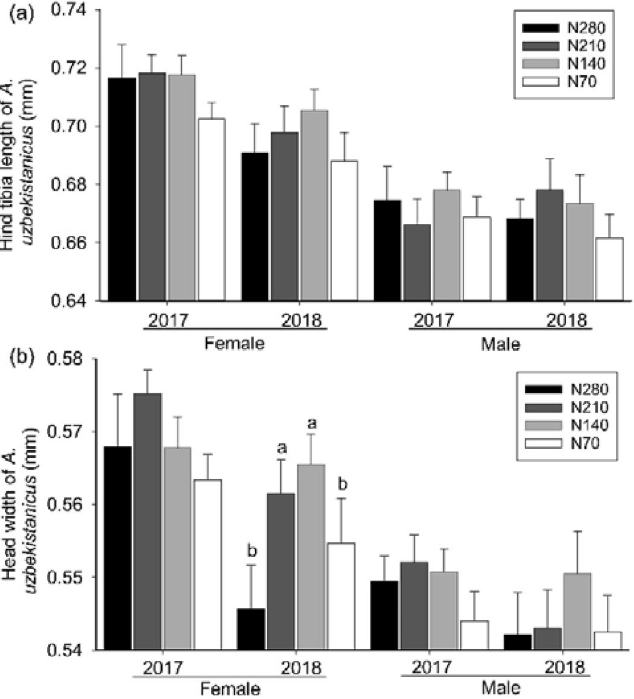
Figure 4. Body size of A. uzbekistanicus ( a : hind tibia length; b : head width) (means + SE) in nitrogen fertilizer plots at the wheat flowering phase during